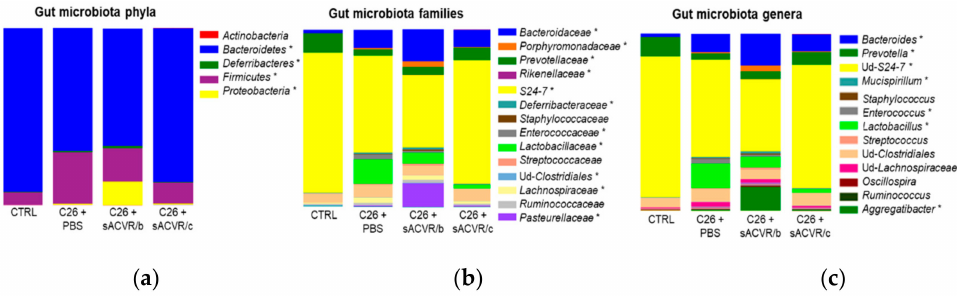
Figure 3. The gut microbiota composition of the mice at ( a ) phylum, ( b ) family, and ( c ) genus level. * Denotes significantly di ff ering taxa between the CTRL and C26 + PBS group (False Discovery Rate (FDR) < 0.05). None of the sACVR administration protocols had significant e ff ects (no di ff erence compared to the C26 + PBS group). The gut microbiota compositions at the phylum level are shown on the left side, the family level in the middle, and the genus level on the right side. Control (CTRL, n = 9), cancer (C26 + PBS, n = 7), the group that received sACVR2B until tumor formation (C26 + sACVR / b, n = 7), and the group that received sACVR2B until death (C26 + sACVR / c, n =